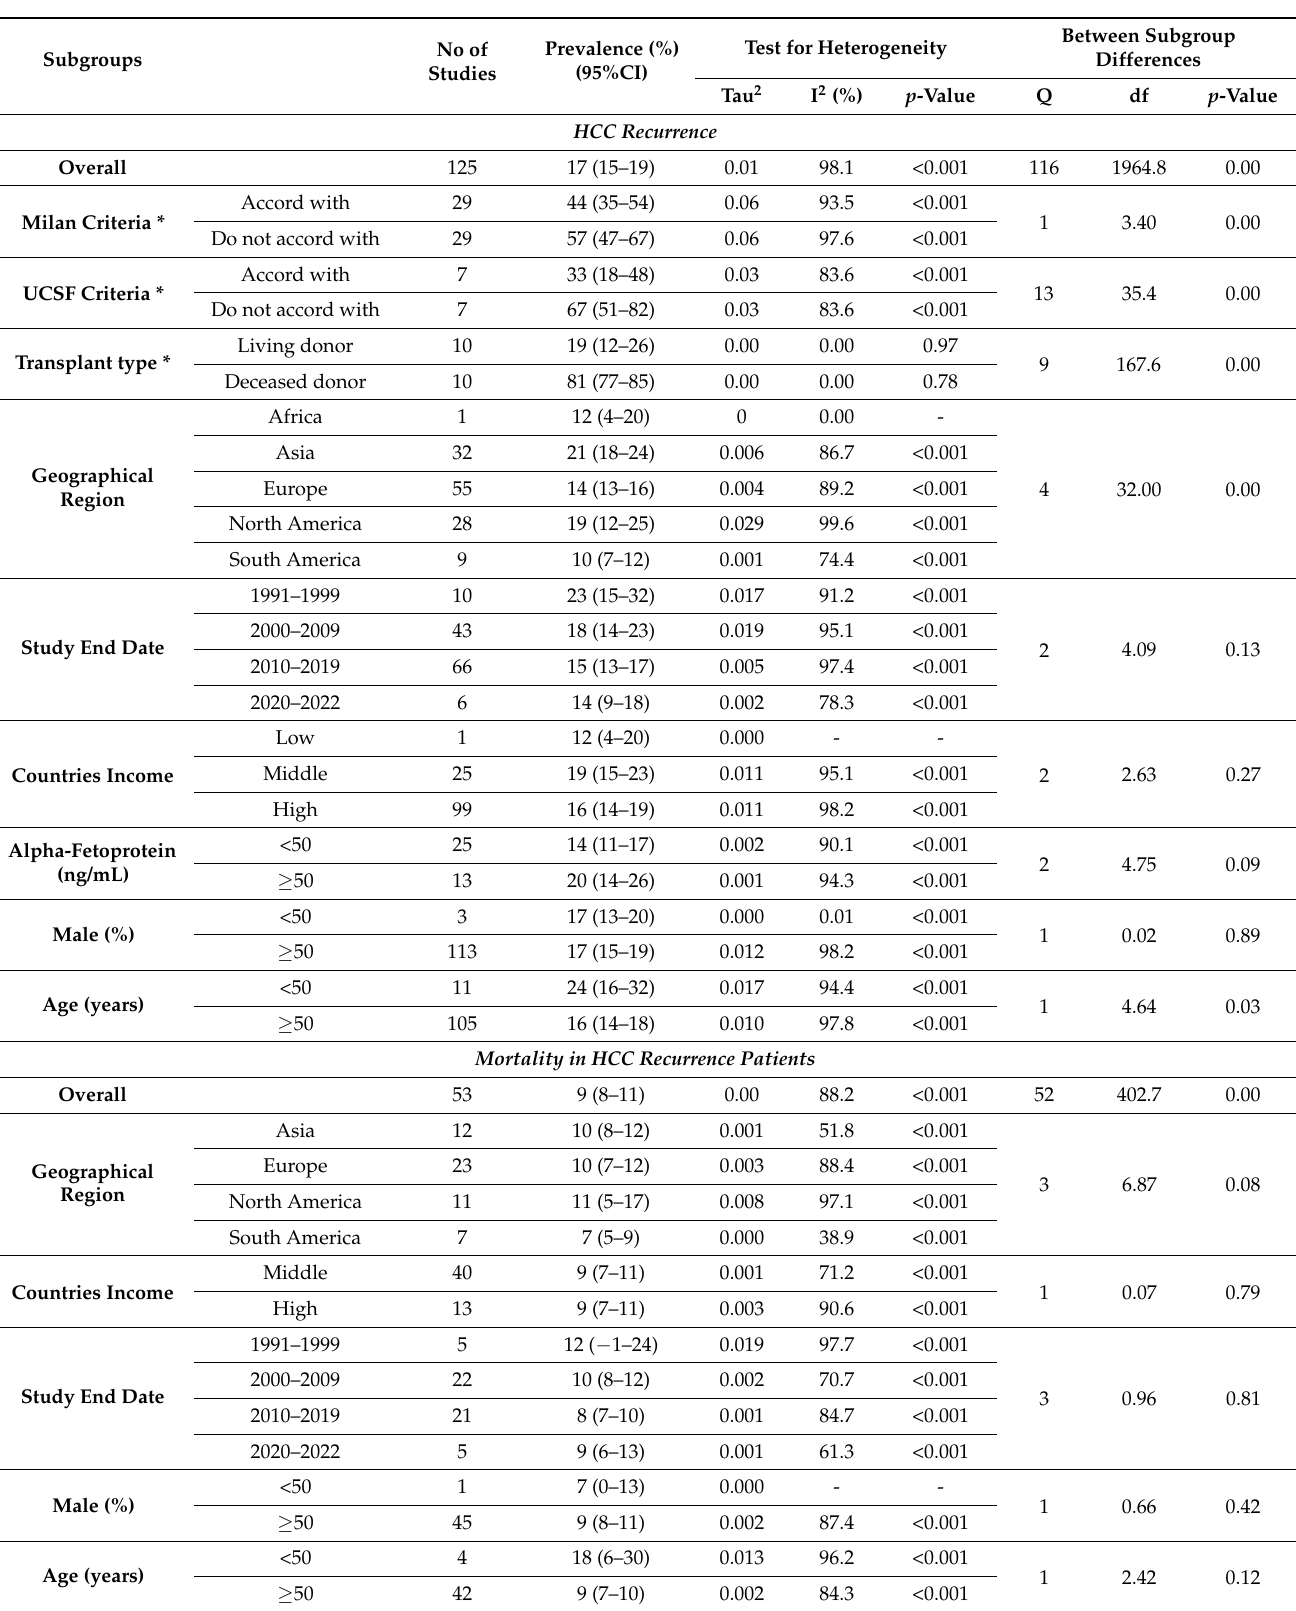
Table 1. Stratified met analysis of the pooled prevalence of HCC recurrence and mortality due to